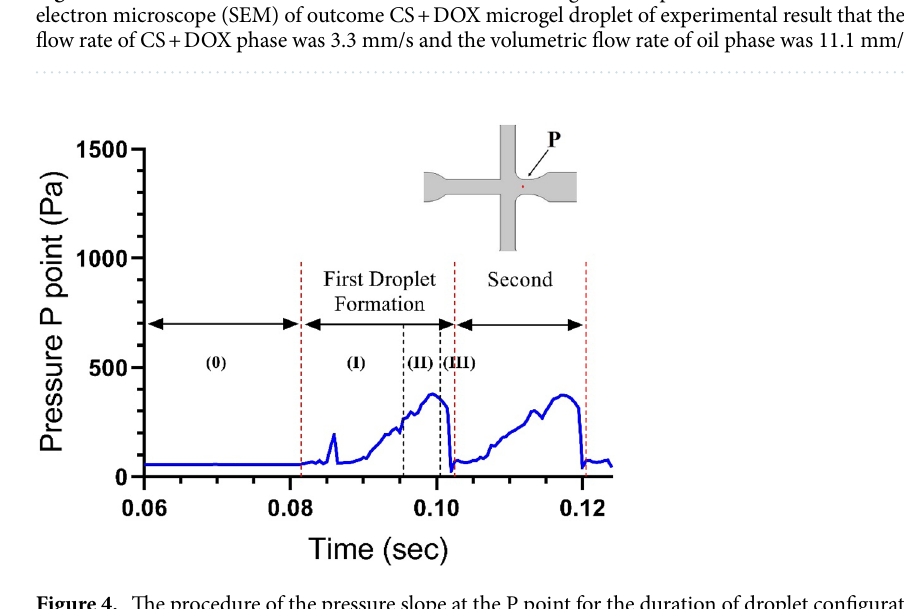
Figure 5.a-i illustrates the pressure fluctuations as a function of the CS + DOX concentration. So by increasing the CS + DOX concentration, pressure fluctuations at the point P are also escalated, which sends back the effect of viscosity of the CS + DOX flow in the vegetable oil flow. Moreover, the amplitude of pressure fluctuations escalates from 320 to 380 Pa by increasing the CS + DOX concentration (see Fig. 5a,d,g). The amplitude of pres- sure fluctuations at the P point for each sub-figures of Fig. 5, is presented in Table 3. On the other hand, the number of fluctuations in the unit of time is directly related to the ratios of CS + DOX and oil velocities, which increases with rising this ratio. The velocity ratio of CS + DOX to vegetable oil at concen- trations of 0.2%, 0.5%, and 1.0% in Fig. 5a–c is 0.297, 0.378, and 0.340, respectively, which shows the dependence of pressure oscillations on velocity ratios. The pressure fluctuation escalated by increasing the velocity ratio and decreasing the velocity ratio. There is a remarkable pressure drop in the CS + DOX streamflow (94.6, 89.1, and 66.67%).